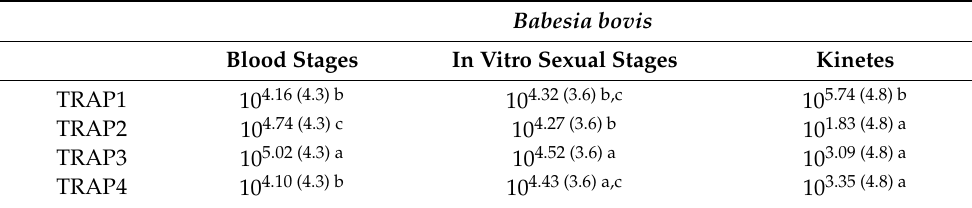
Table 3. TRAP family transcript expression levels in B. bovis blood, sexual, and kinetes